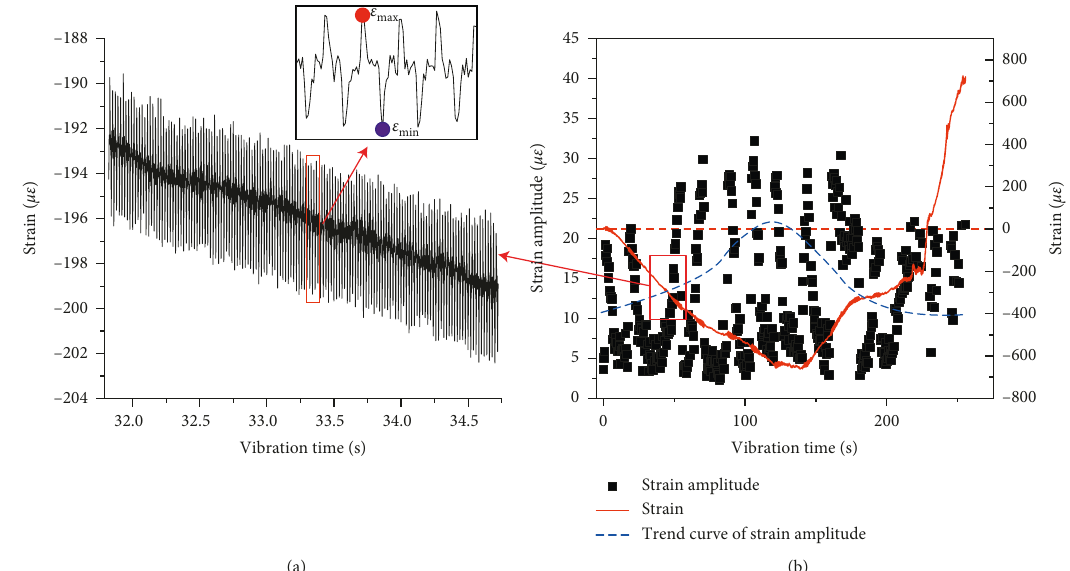
Figure 12: Change process of strain amplitude. (a) Detail of the strain data. (b) Development of strain amplitude and